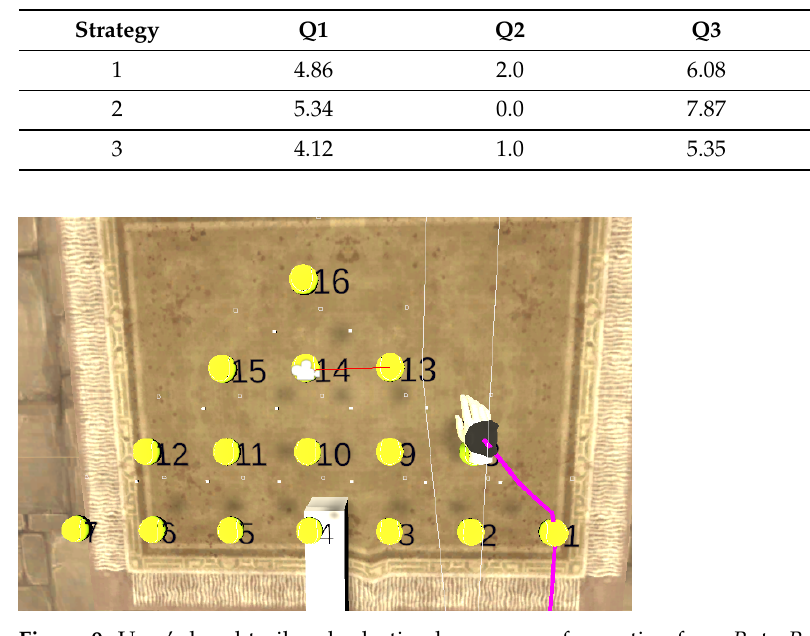
Table 1. Strategy results for the user’s hand trajectory from P 1 to P 16 .